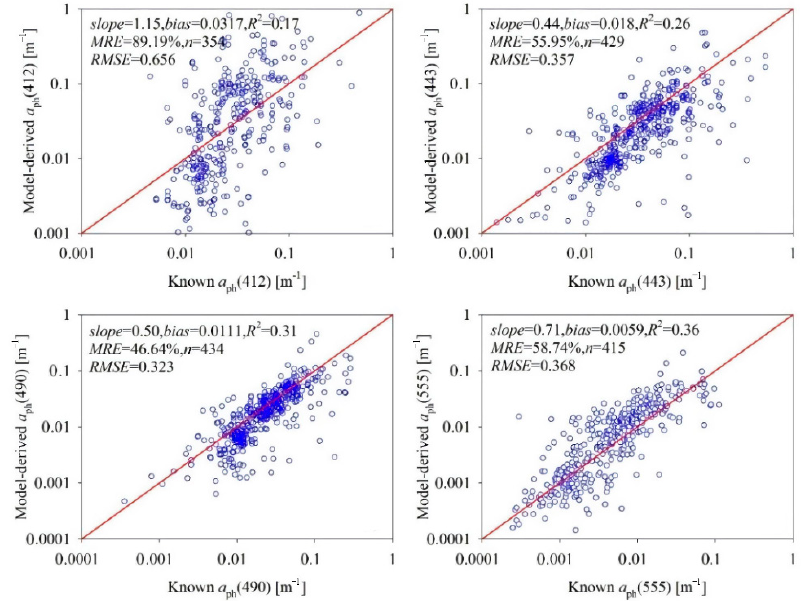
λ ) produced using satellite